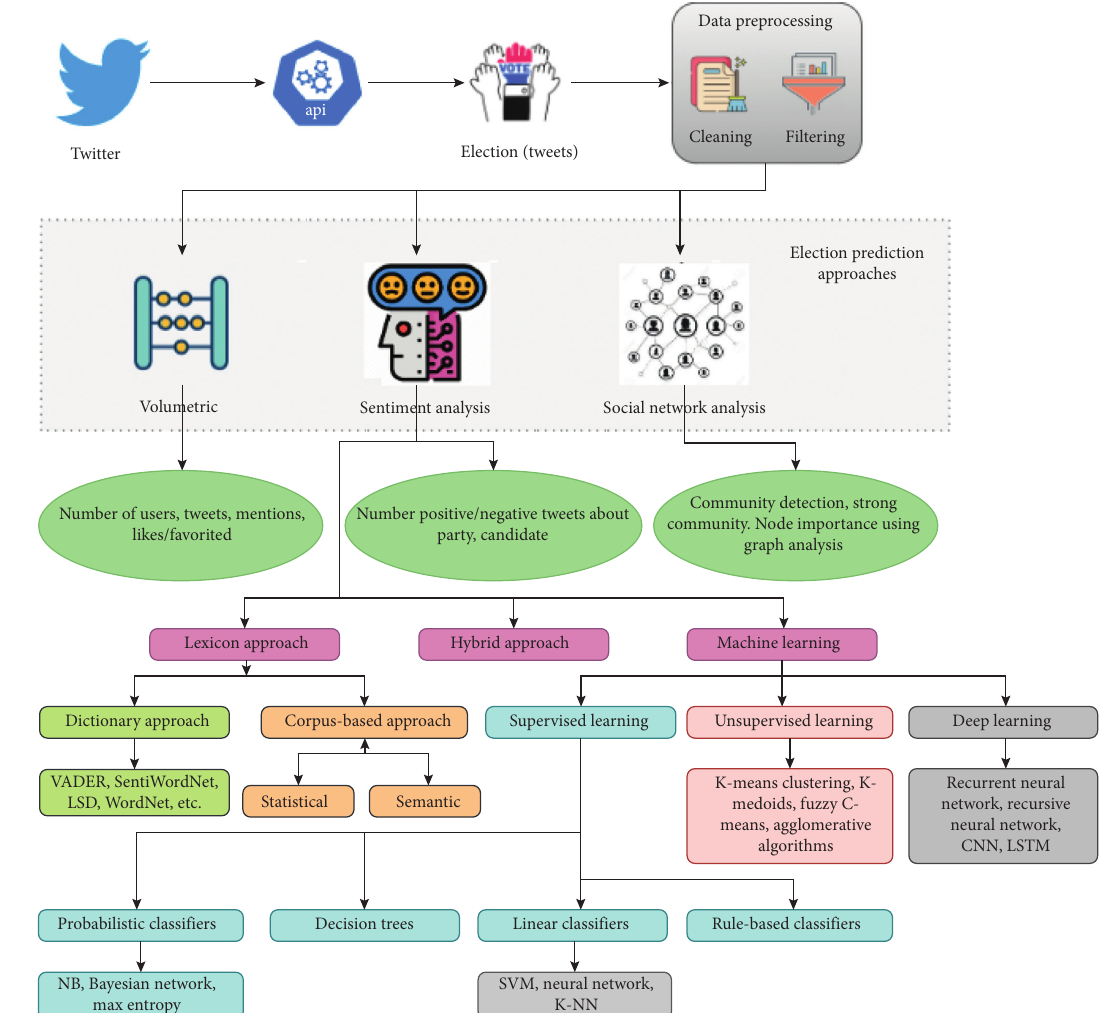
Figure 2: Overview of election prediction approaches and